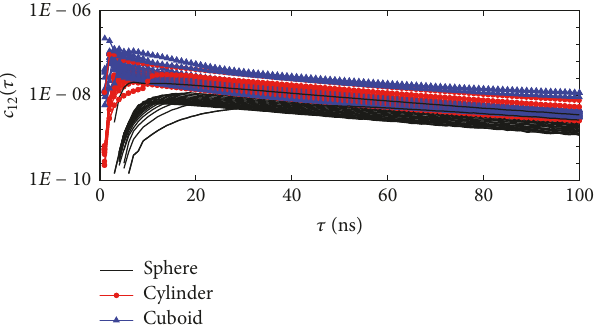
Figure 7: 63 groups of correlation functions of 3 different geometry properties.